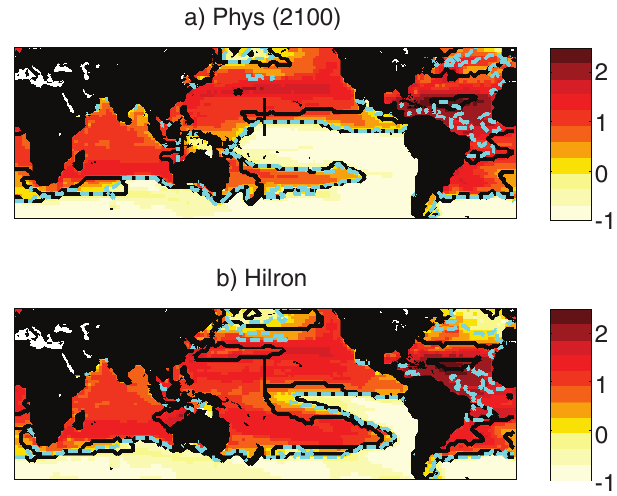
I ∗ Fe (log unit- R NFe I ∗ N B